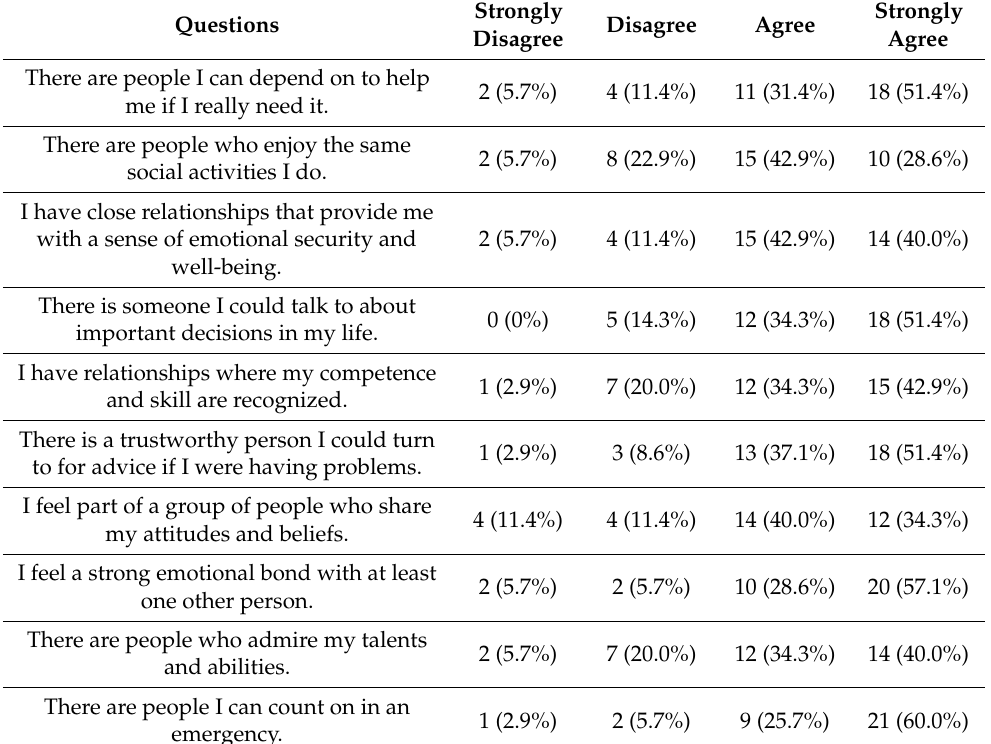
Table 5. Answers of 40 parents of children with disabilities related to their social life during the pandemic in Quebec (Canada) 1